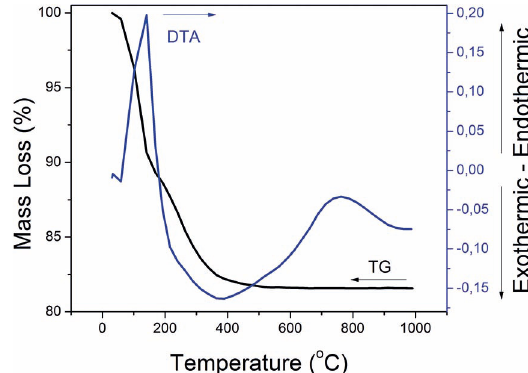
Figure 2. TG and DTA for Titanium dioxide powder previous to any thermal annealing. This powder became P4 sample after complete annealing as described in Table 1. The endothermic peak shown pellets. The main diffraction peaks of Figure 1. XRD of TiO 2 in the DTA, from 400 o C to 1000° C is not accompanied by mass samples P1 to P4 are displayed. Samples P1 and P4 have rutile phase loss in TG, which characterizes the phase transition anatase / (catalog JCPDS-ICDD 2003 file number 89-4920) after TT 1000 o C, but some anatase peaks (*) still appear in the P1 diffractogram. Samples P2 and P3 have the anatase phase (catalog JCPDS-ICDD 2003 file number 78-2486), after TT 500 o C, but also show peaks of rutile phase (#) .